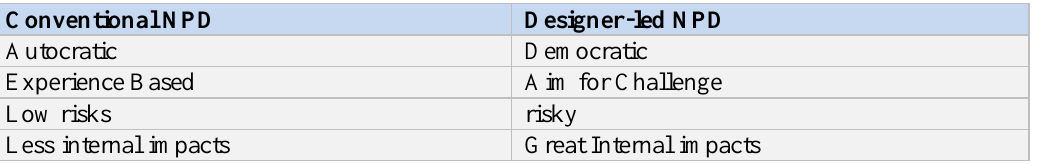
Table 6 : Differences of two NPDs in Practical